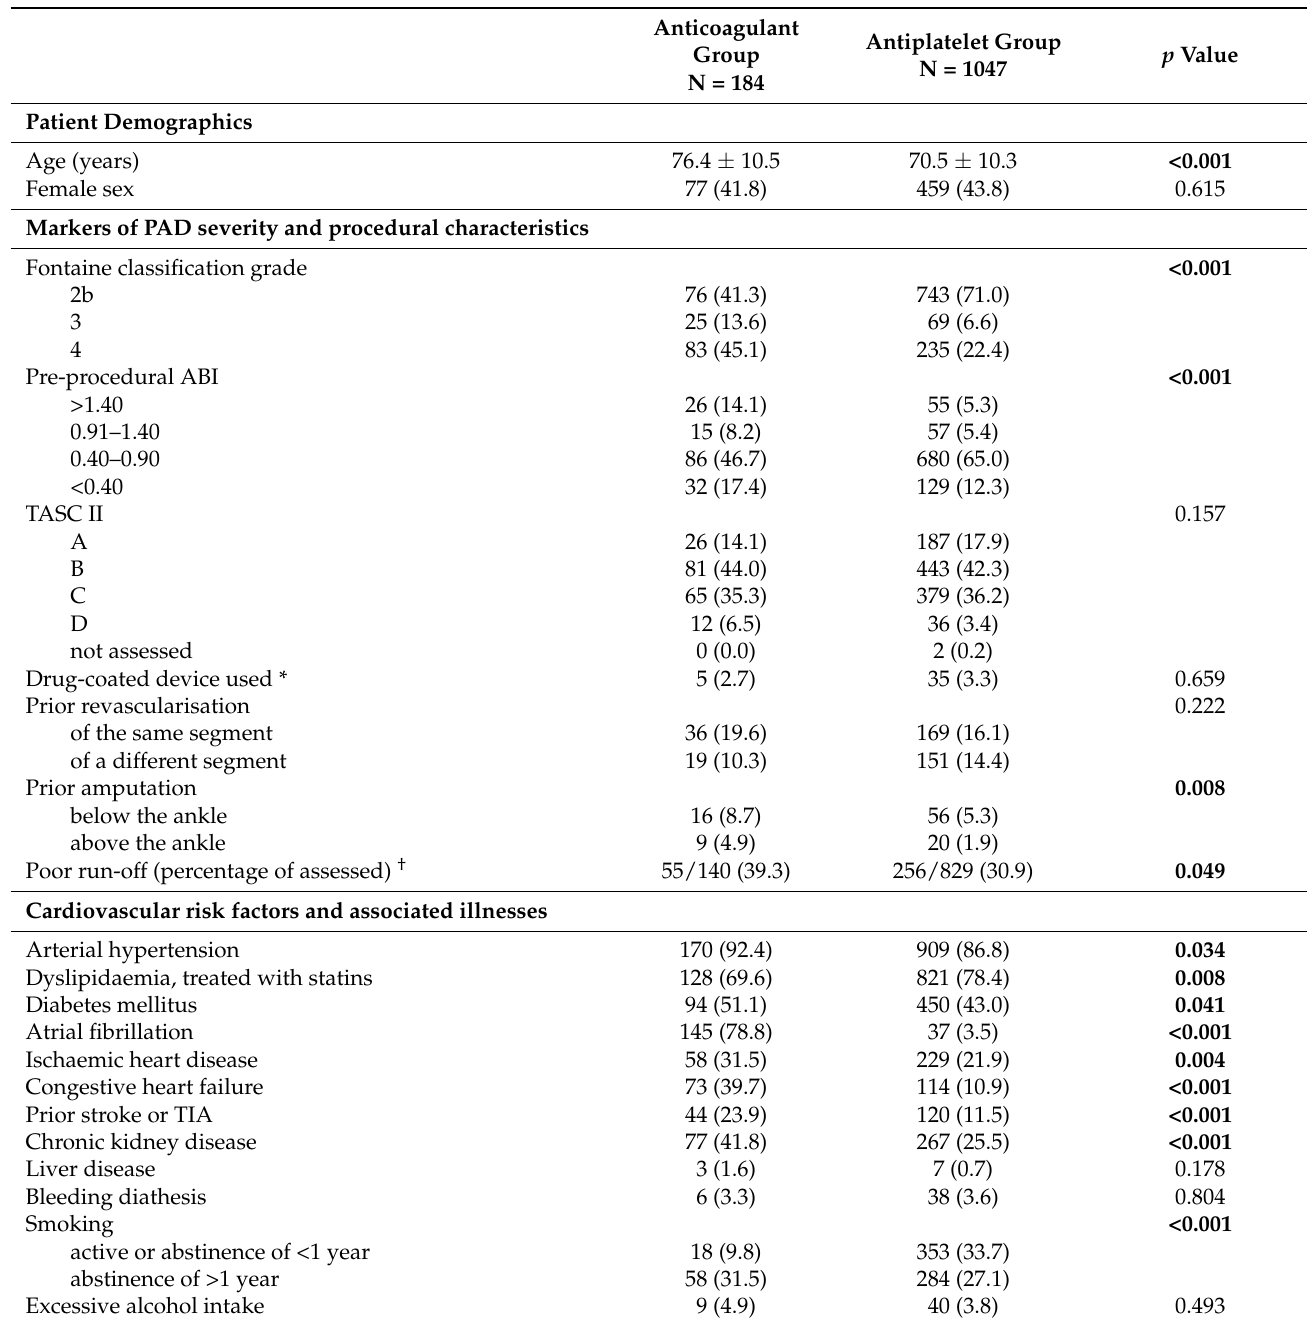
Table 1. Baseline characteristics of the group of patients treated with full-dose anticoagulant therapy and the group of patients treated with antiplatelet